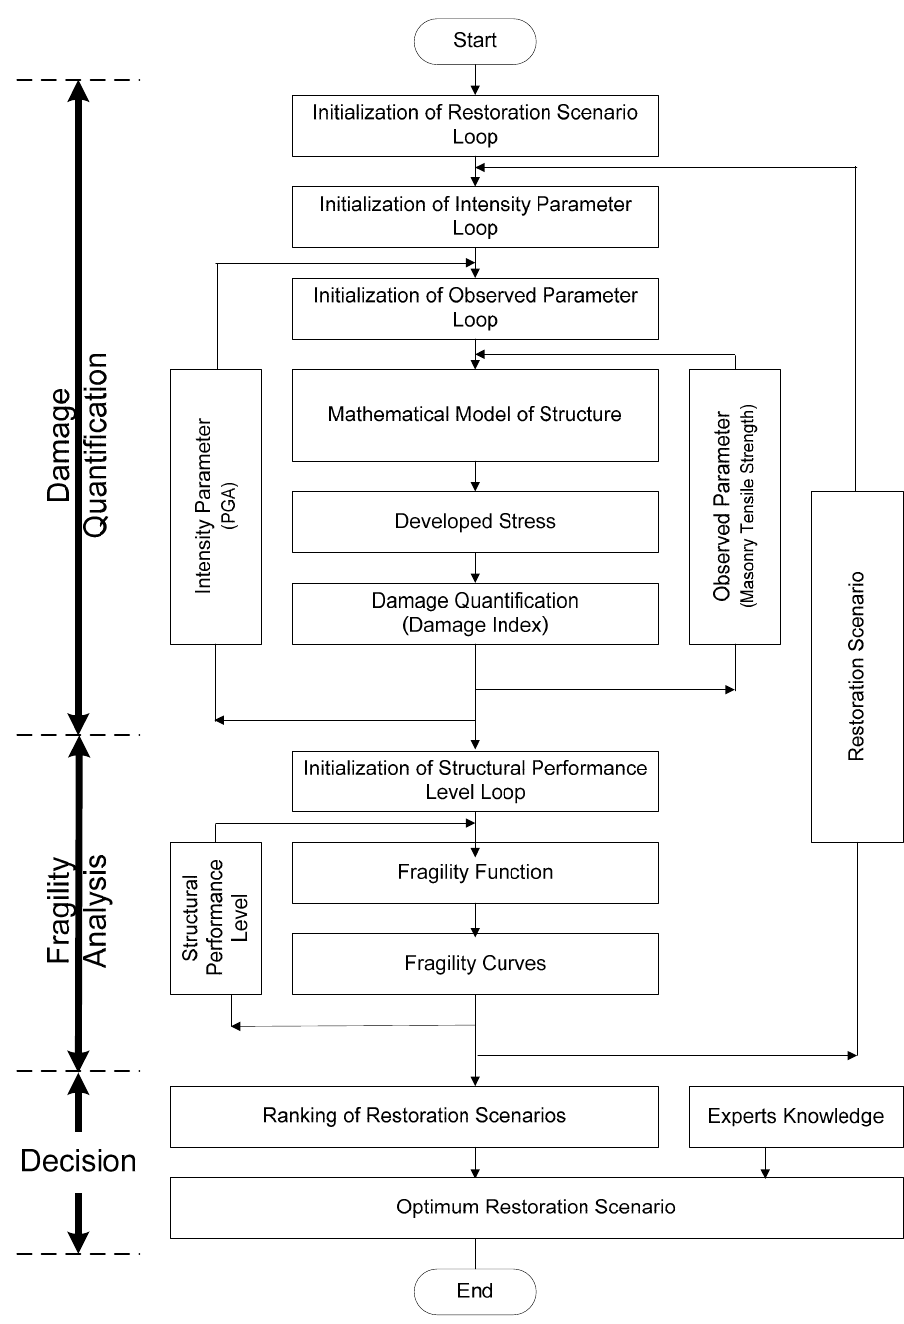
Figure 2. Flow chart of the proposed methodology.